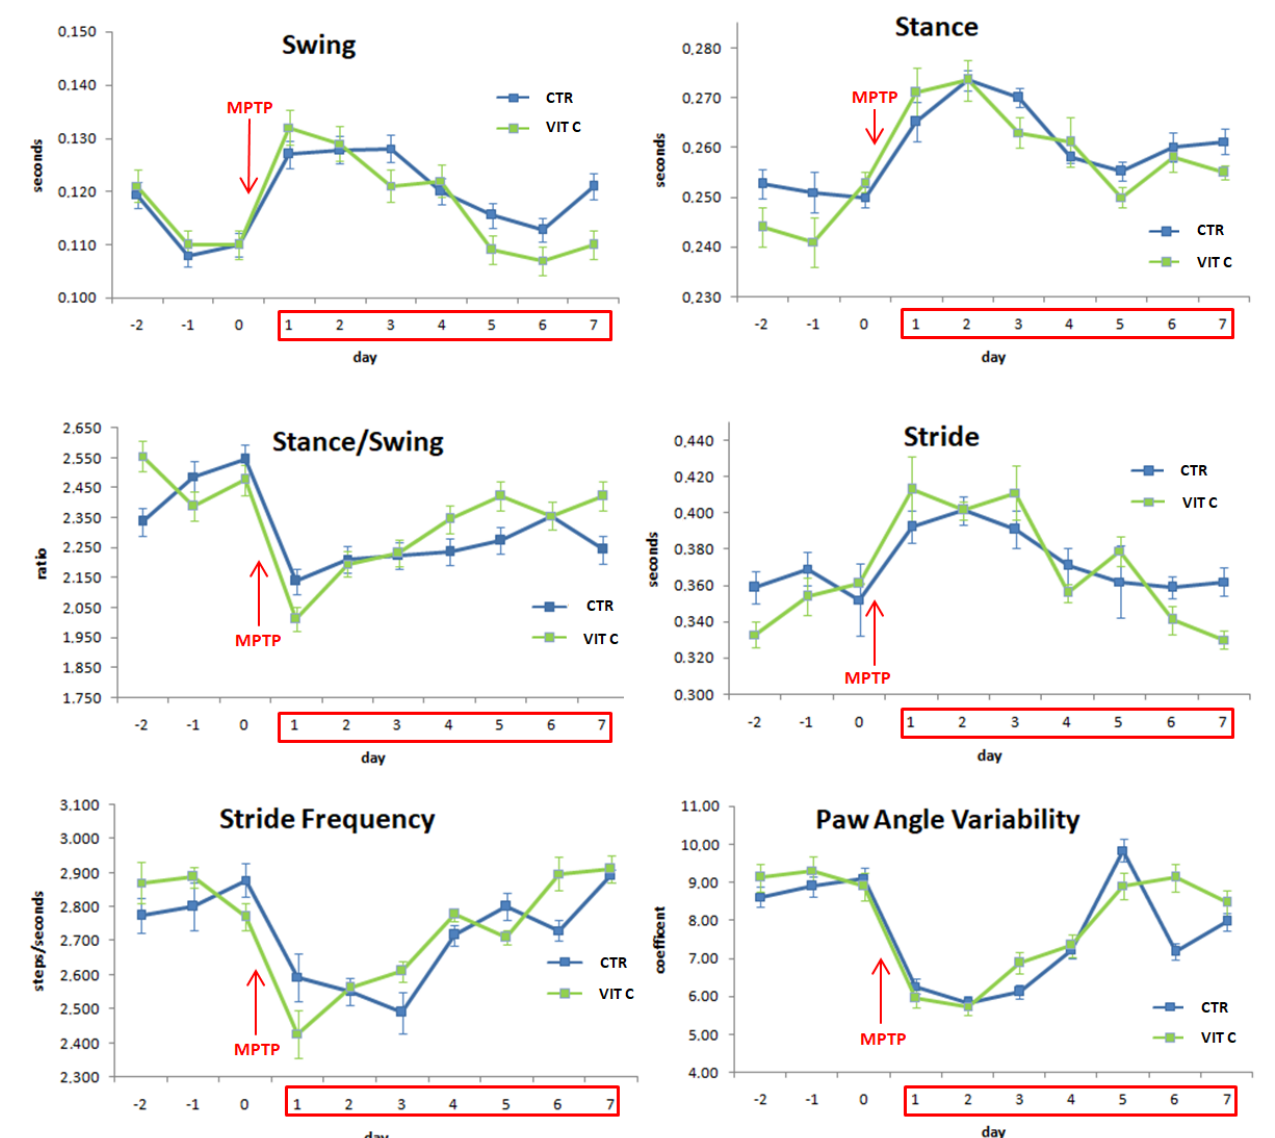
Figure 5. Treadmill-based measurement of gait properties. Plots showing swing time, stance time, stance/swing ratio, stride duration, stride frequency, and paw angle measured in mice treated with Vitamin C (Vit C) or untreated. On day 0, MPTP was administered to all mice. All values are expressed as means ±SD ( n = 5 per group, 5 replicates,* p < 0.05 day 0 vs. day 1, # p < 0.05 Vit C vs. CTR).